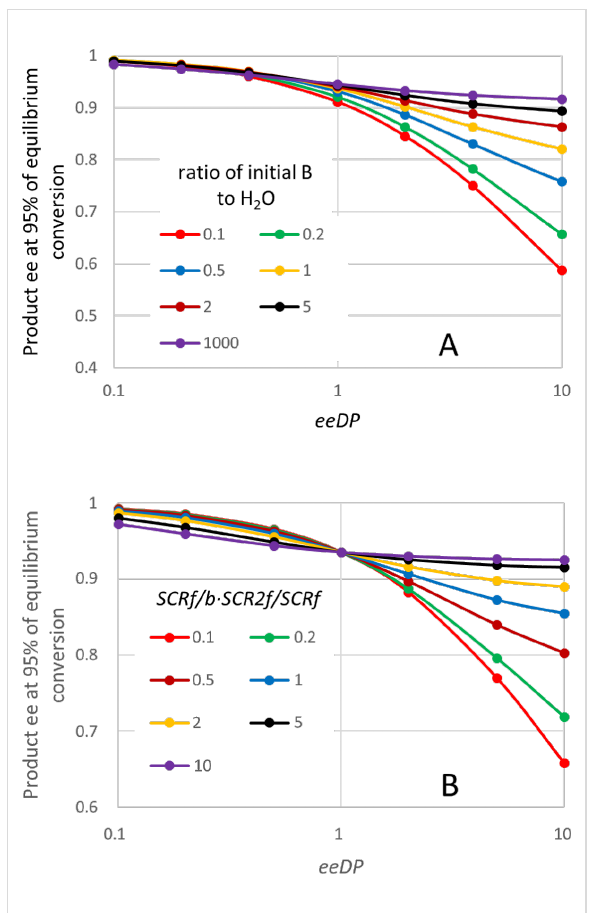
Figure 11: Effects on the ee at high conversion for diacid ester synthe- sis, “ping-pong, both” kinetics. Parameters not varied were: S 0 = 0.2 M, B 0 = 0.4 M, K eq = 10, E = 39, K S = 0.1 M, k 2R = 1000 s − 1 , SCR2f / SCRf = 1, k 4R / k 2R = k 2R / E · k 2S = k 4R / E · k 4S = 1, k − 1R / k 2R